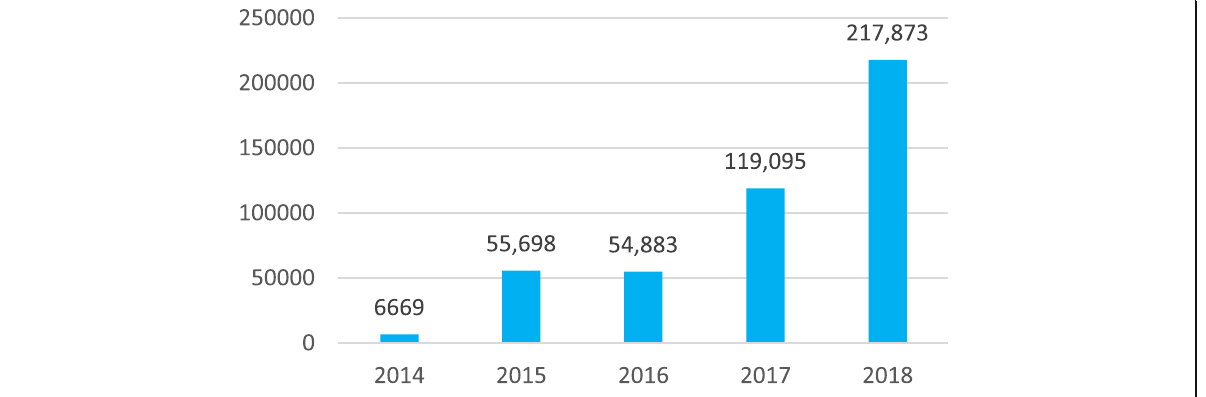
Fig. 2 Number of accesses by year (Source: Springer). Accesses are defined as the number of times full text or PDF versions of articles are accessed directly from the journal website and SpringerLink. Downloads are defined as HTML, LookInside, PDF, and Epub click. Please note that this does not include article downloads from mirror databases such as PubMed Central